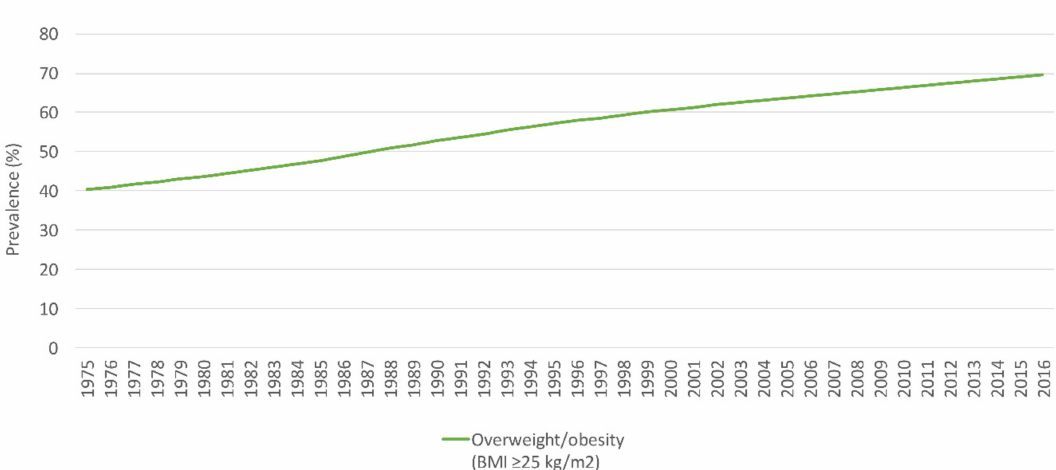
Figure 6. The trend in the prevalence (%) of overweight and obesity (BMI ≥ 25 kg/m 2 ) among adults in Jordan, modeled data (1975–2016). Abbreviations: BMI: body mass index; kg: kilogram; m: meter. Source: WHO, 2021